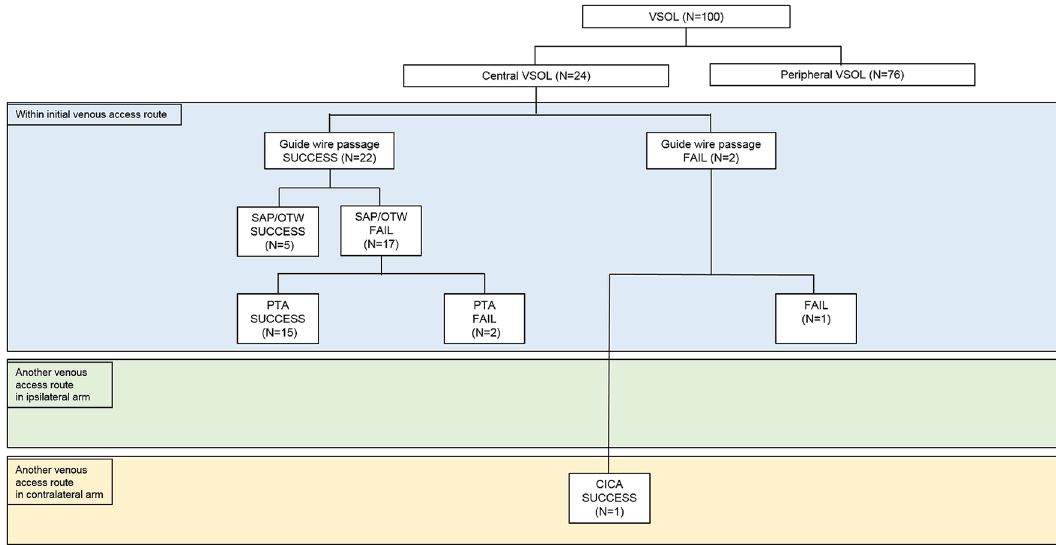
Figure 2. Flow diagram summarizing the various strategies used in patients with central venous steno- occlusive lesion. VSOL venous steno-occlusive lesion, SAP/OTW selecting alternative pathway/over the wire technique, PTA percutaneous transluminal angioplasty technique, RIA re-puncture in ipsilateral arm technique, CICA catheter placement in contralateral arm technique.